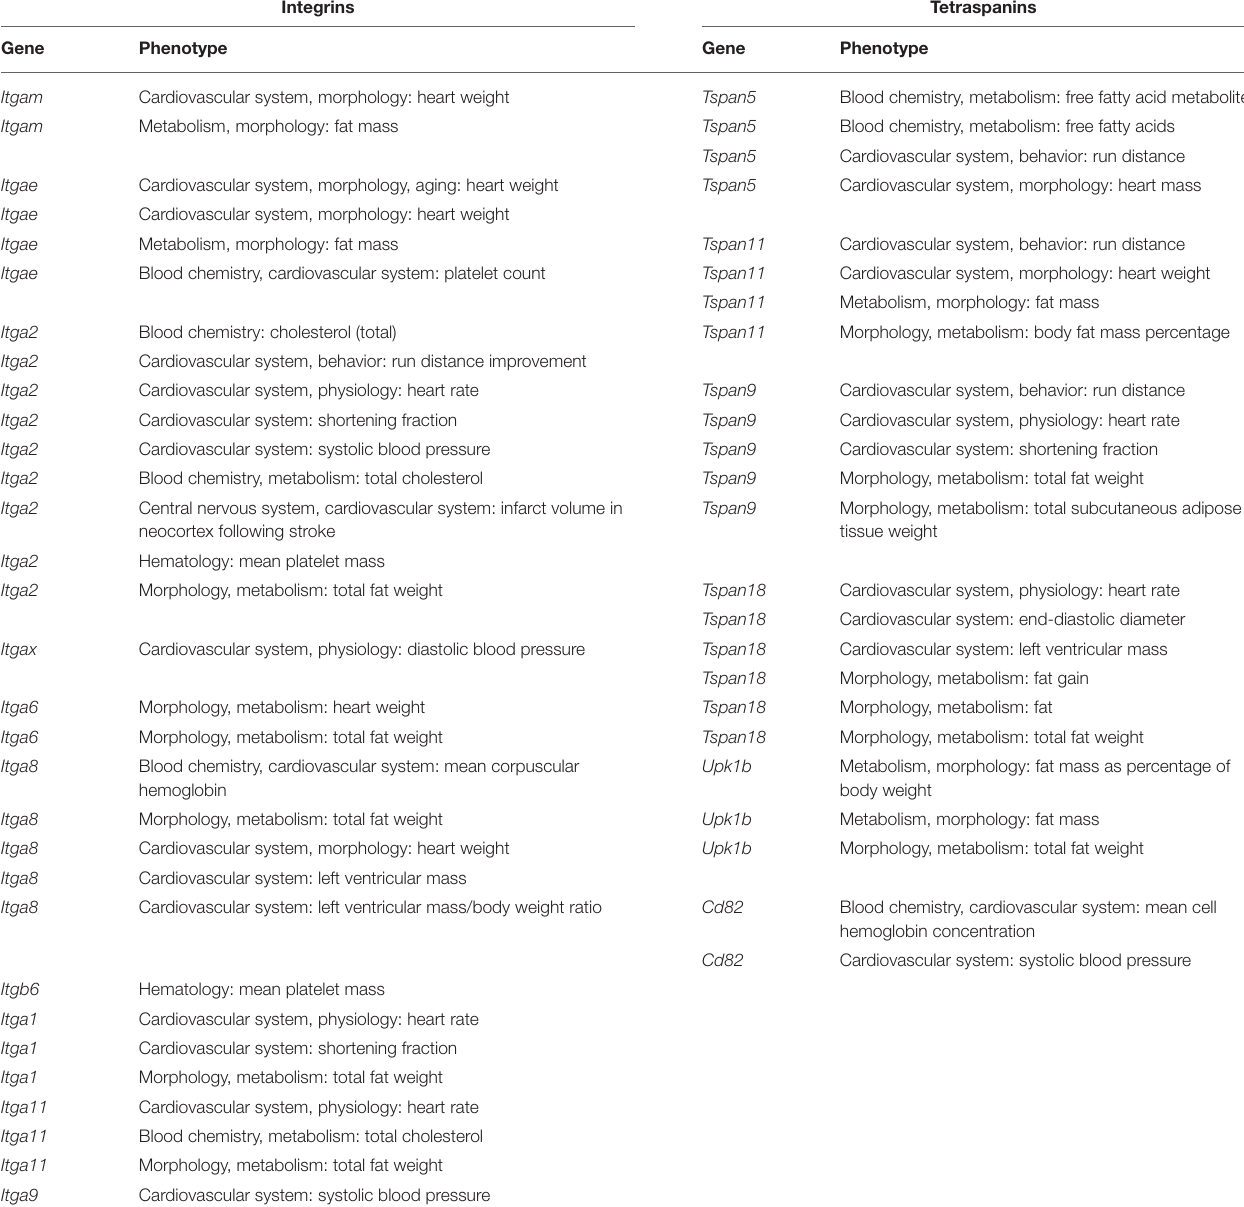
TABLE 2 | Associations of integrin and tetraspanin genes with cardiovascular phenotypes in mice. Integrins Tetraspanins Gene